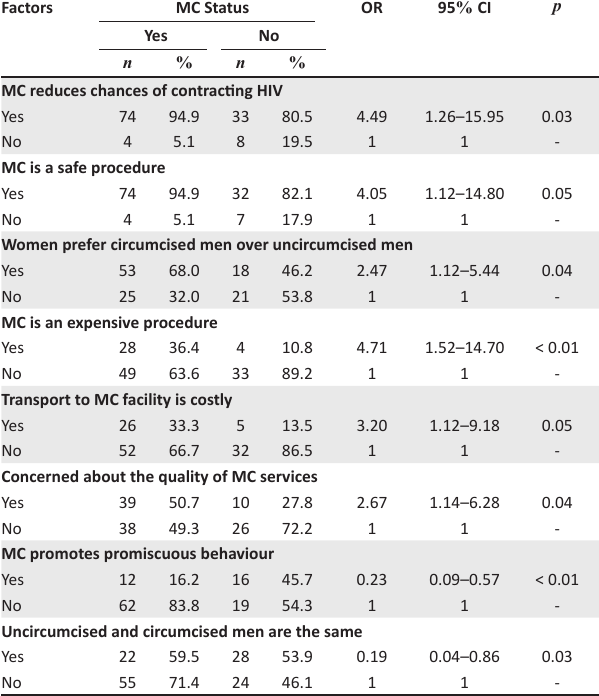
TABLE 3: Factors associated with circumcision status among male college students, Ndola, Zambia ( N = 136).